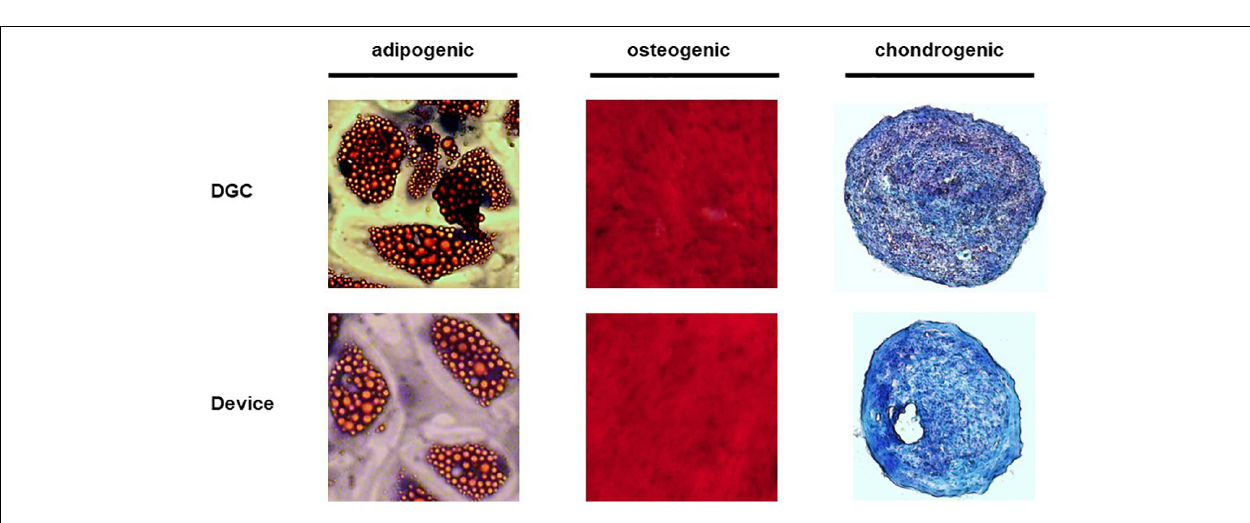
FIGURE 6 | Trilineage differentiation potential. The in vitro differentiation potential of MSCs was assessed at P3 with Red-Oil-O staining (adipogenesis), Alizarin red staining (osteogenesis) and Alcian blue/nuclear fast red staining (chondrogenesis). Original magnification × 100 for osteogenesis and chondrogenesis, × 400 for